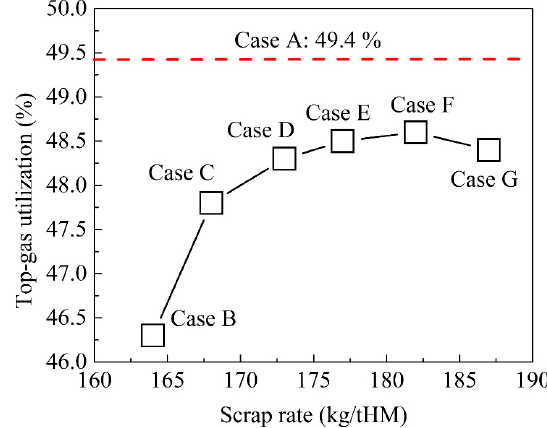
Figure 6. Change in BF top-gas temperature with scrap rate.